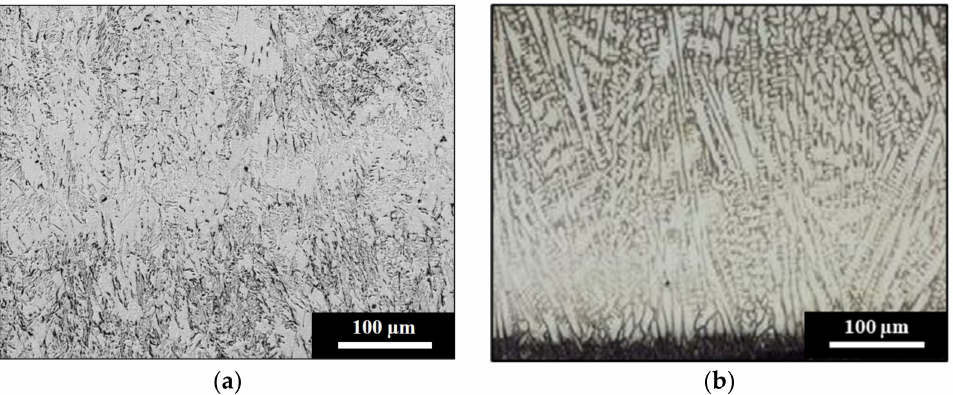
Figure 5. Cladding microstructure on hypereutectoid rail from ( a ) SS415 deposition containing partially tempered martensite, and ( b ) dendritic microstructure of the Stellite 6 cladding layer, published by Lai et al.